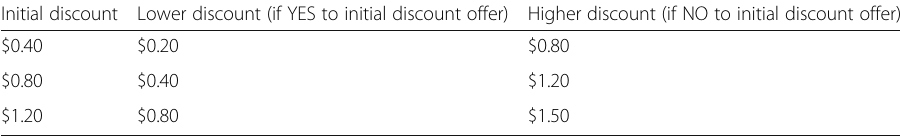
Table 2 Discount bids